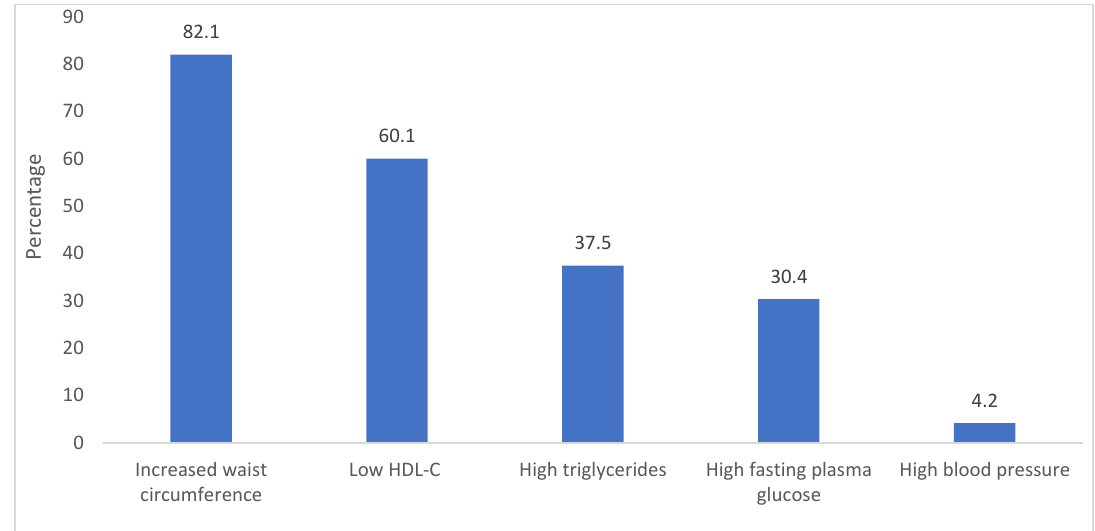
Figure 1. Prevalence of metabolic syndrome criteria in the total sample of nurses. HDL-C: high-density lipoprotein cholesterol.